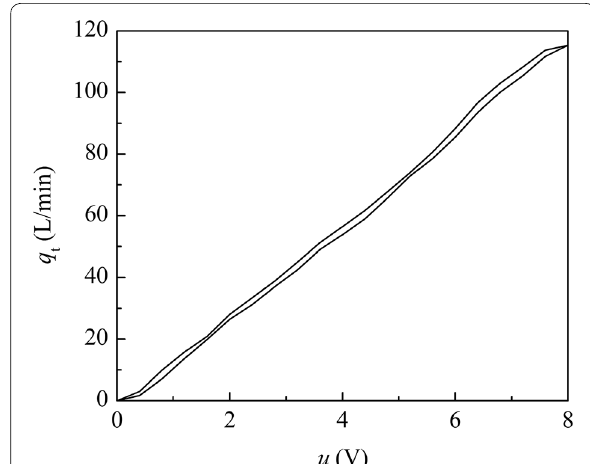
Figure 13 Spool displacements in the pilot stage with the flow control method